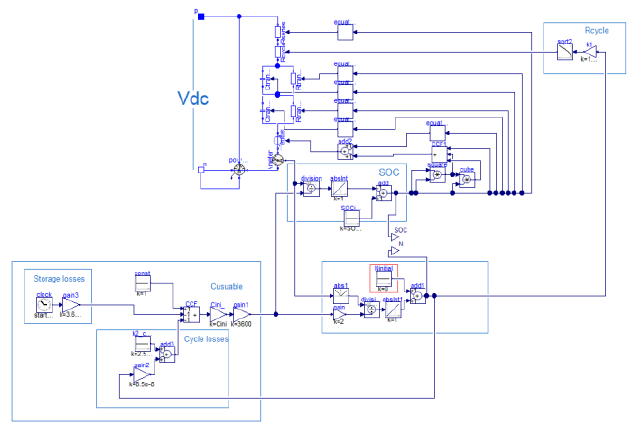
Figure A10. Modelica’s lithium-ion model.